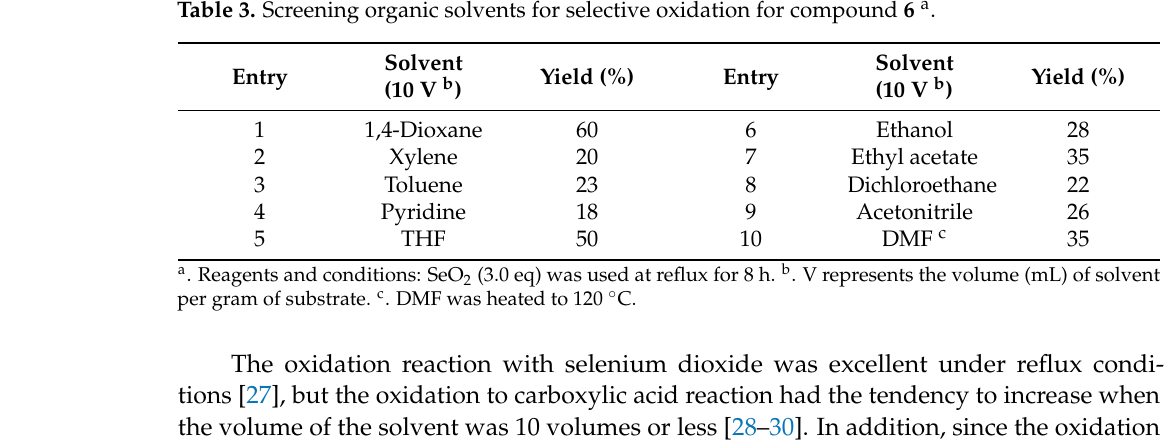
Table 3. Screening organic solvents for selective oxidation for compound 6 a .